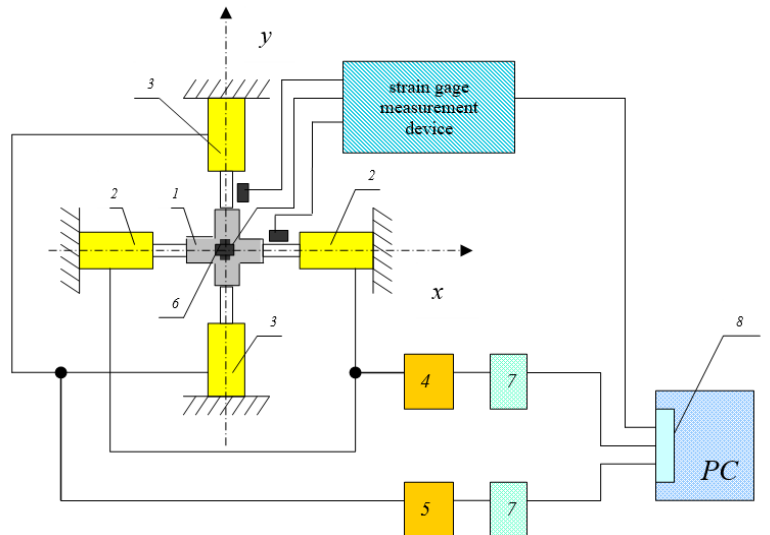
Figure 7. Diagram of the control circuit at the object level (1—metal cruciform sample (specimen), 2—hydraulic cylinders with hydraulic fluid lines for the x-axis, 3—hydraulic cylinders with hydrau- lic fluid lines for the y-axis, 4—proportional pressure-reducing valve PDR08P-01 for the x-axis, 5— proportional pressure-reducing valve PDR08P-01 for the y-axis, 6—strain gauge sensors, 7—meas- uring card RB-01-TU-002-100-E, 8—multifunctional measuring card MF 624 (MF 604) for data col- lection and computer processing).